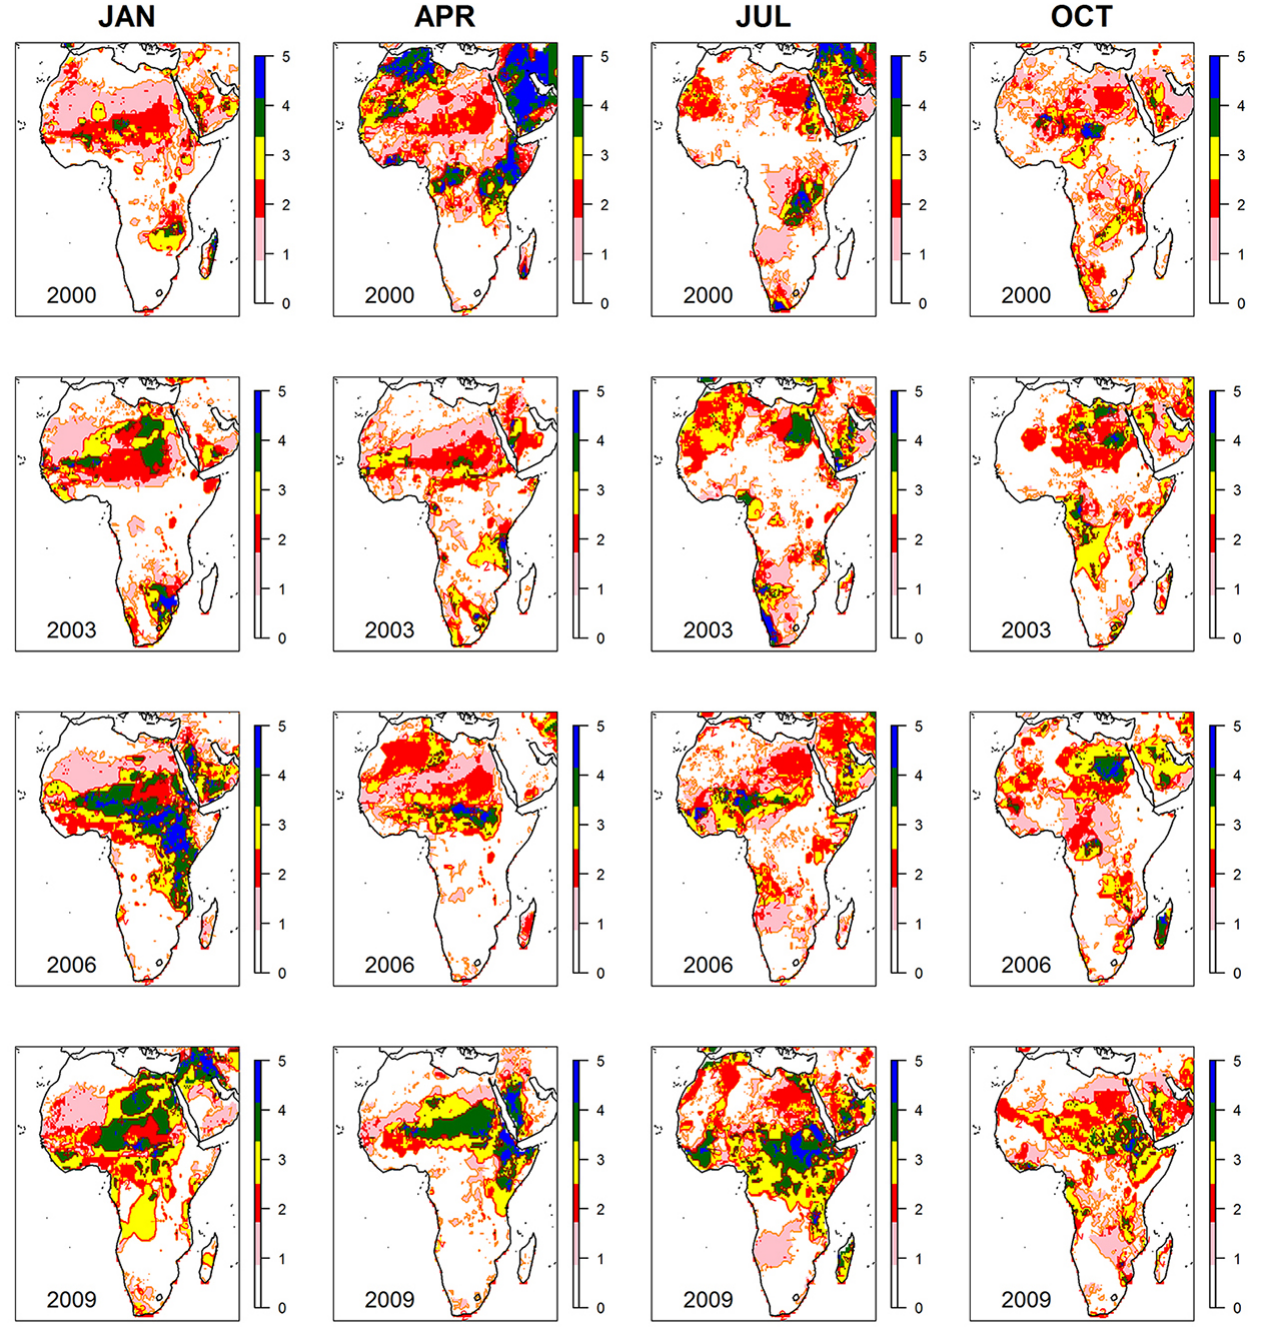
Fig. 6. Month by month evolution of droughts in 2000, 2003, 2006 and 2009 according to grid cells with SPI-3/SPEI-3 computed using ERA-I GPCP, and TRMM below − 1.0. Values are ranged between 0 (no data set with SPI-3/SPEI-3 below the threshold) and 5 (all data sets below